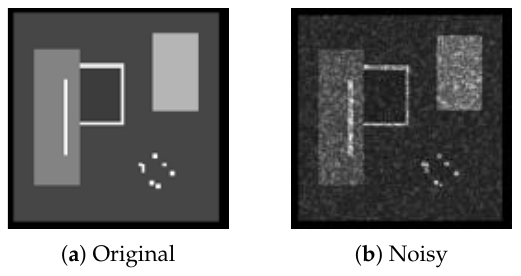
Figure 4. Original image and simulated noisy image.